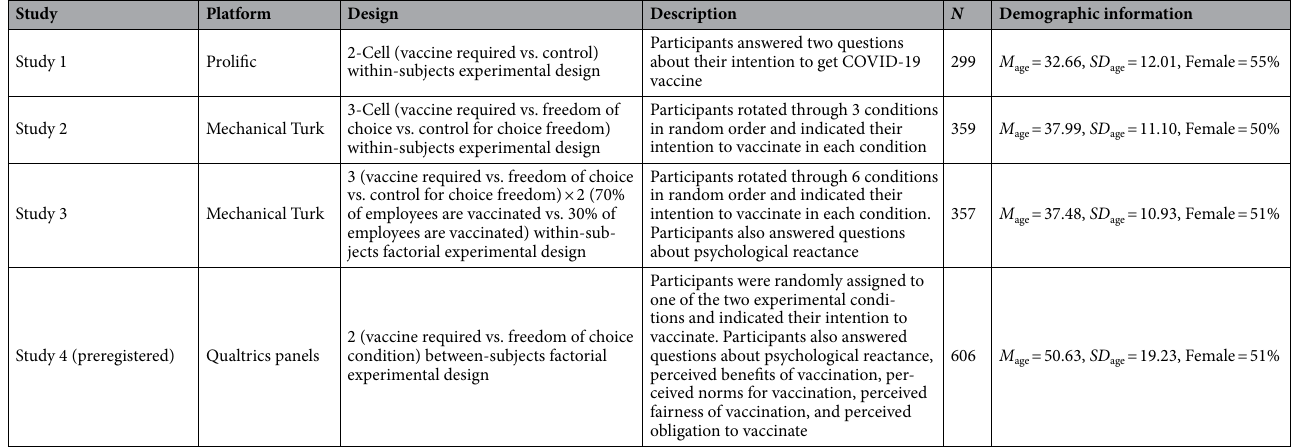
Table 1. Summary of methods: Studies 1–4.